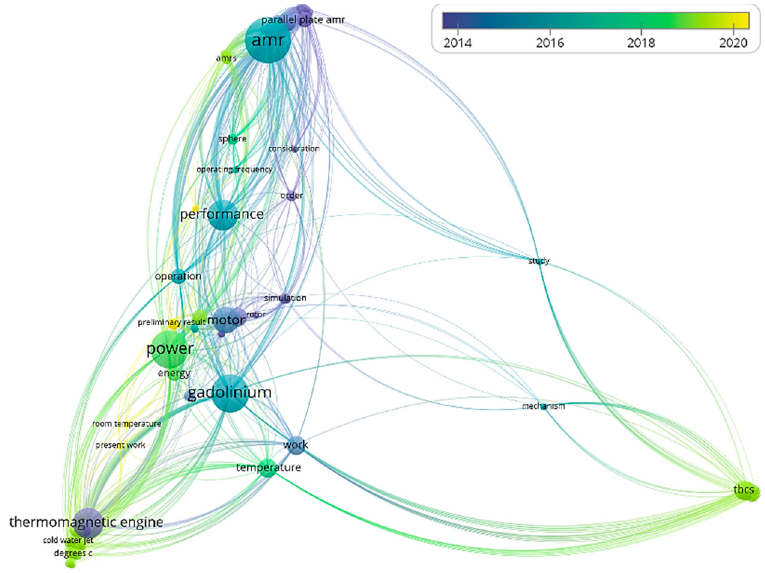
Figure 1. Bibliometric network presenting the evolution of gadolinium motor since 2014 to 2020.